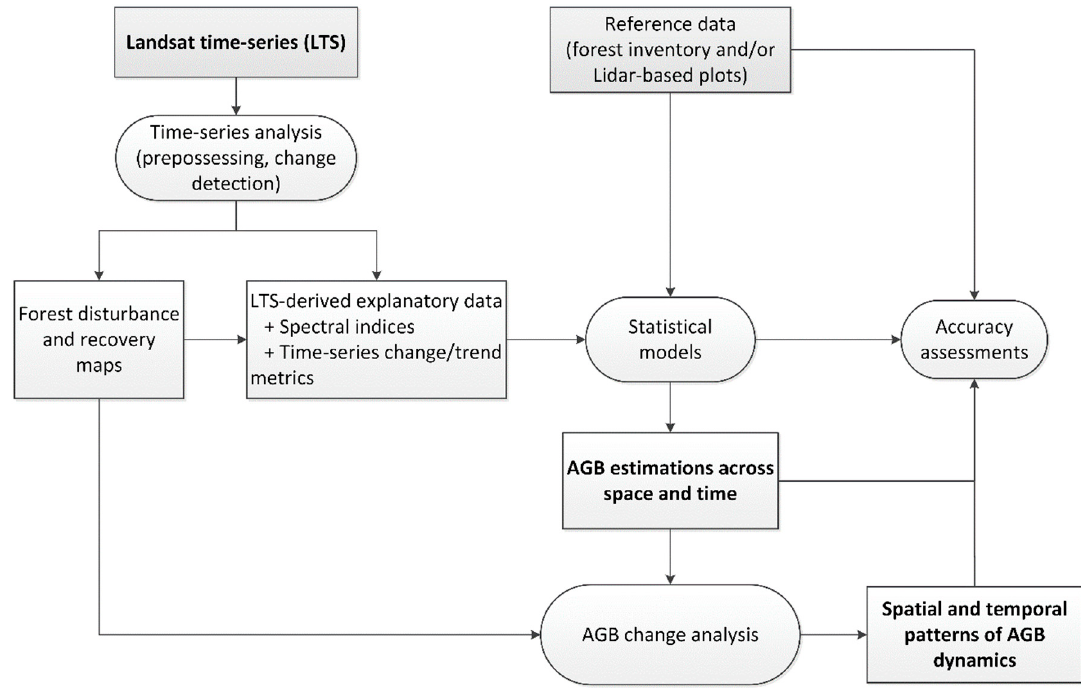
Figure 1. A common concept for estimating AGB dynamics using LTS data.